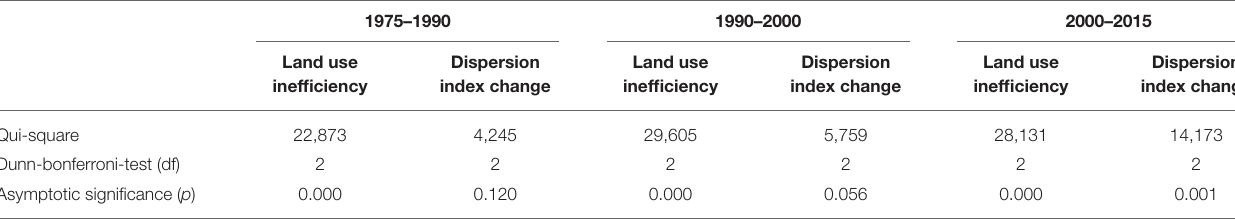
TABLE 4 | Results of the Kruskal-Wallis-test